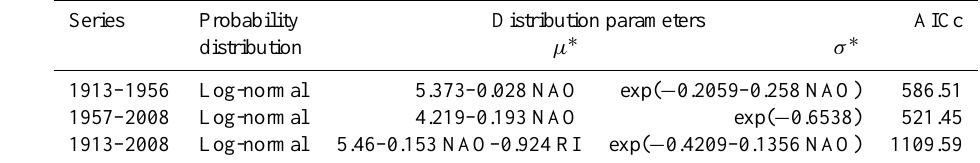
Table 2. Results of the marginal distributions with NAO and RI as the explanatory variables of distribution parameters.